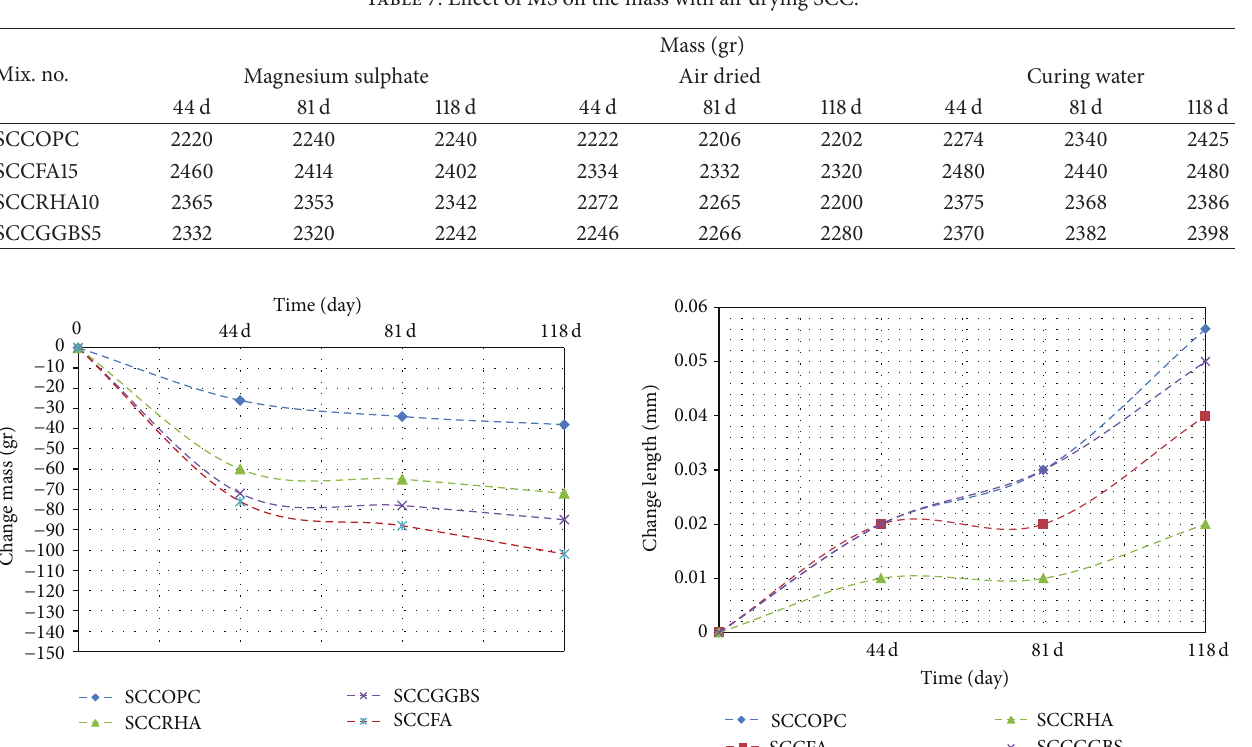
Table 7: Effect of MS on the mass with air drying SCC.